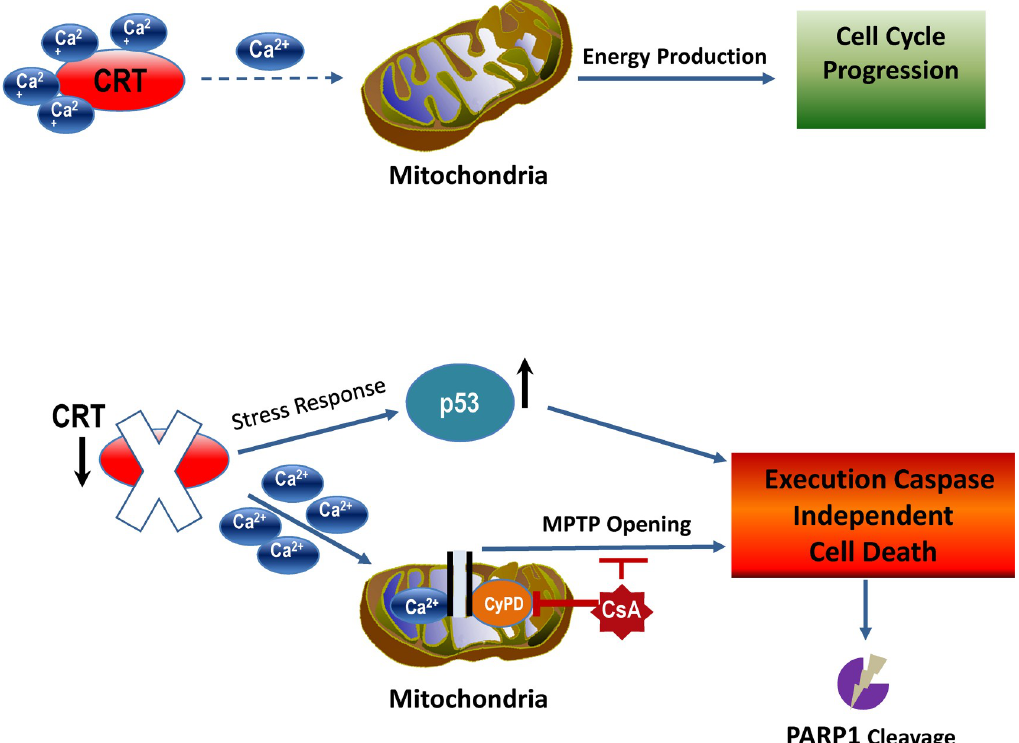
Fig 8. General model of the CRT prosurvival function in the cell. CRT, calreticulin; mPTP, mitochondria permeability transition pore; PARP, poly ADP ribose polymerase.